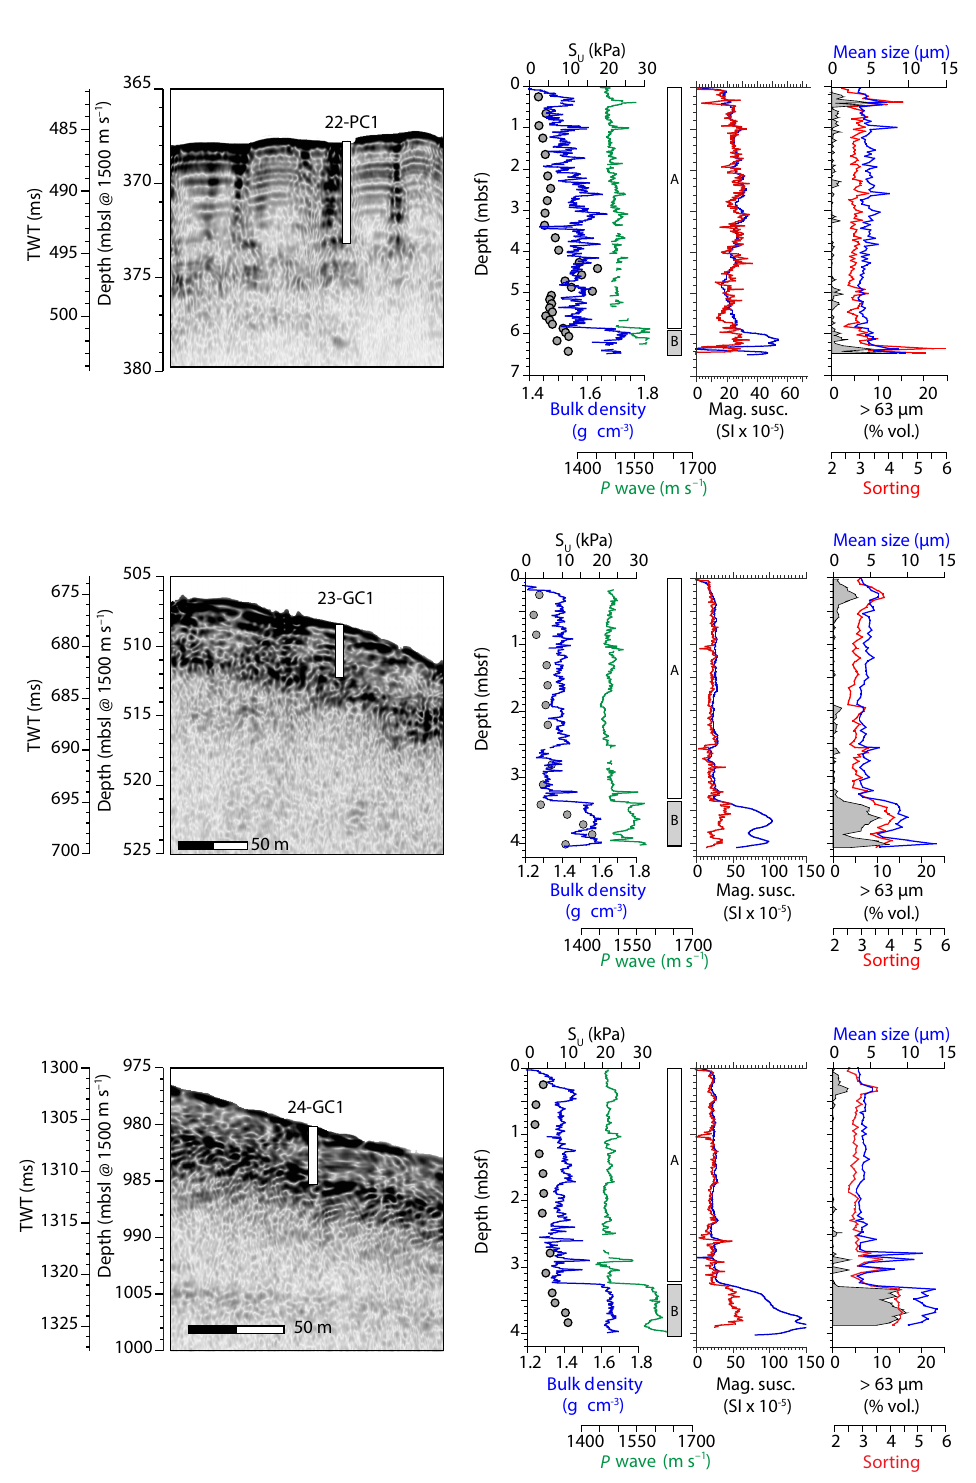
Figure 8. Detailed view of sub-bottom data, penetration and physical property measurements of cores 22-PC1, 23-GC1 and 24-GC1. All cores penetrate down to a strong reflector that marks the top of an acoustically transparent interval. The base of all the cores recovered a coarser-grained, poorly-sorted unit displaying a higher bulk density and magnetic susceptibility. This is interpreted as a